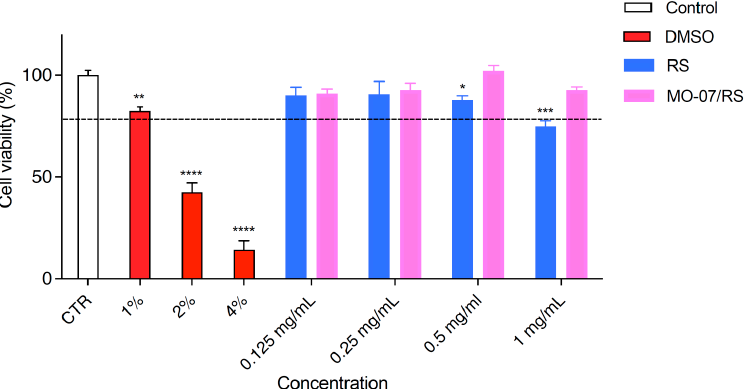
Figure 3. Viability of HaCaT cells incubated with different concentrations of RS and MO-07/RS (24 h). The control is represented by untreated cells in DMEM and set at 100%; DMSO in three different percentages (1%, 2%, and 4%) was used as the positive control. The percentage of viable cells in respect to the control was reported as the mean ± SD of five independent experiments. Dotted lines indicate 80% cell viability. * p < 0.05, ** p ≤ 0.01, *** p ≤ 0.001, and **** p ≤ 0.0001, treatments versus control (one-way ANOVA test).